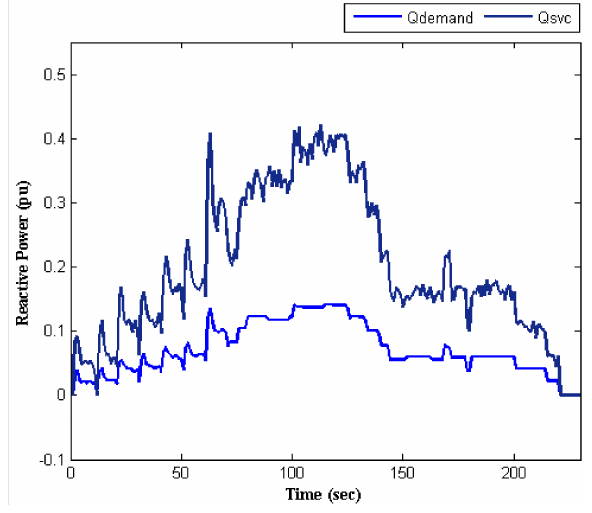
Figure 12. Reactive power profile.